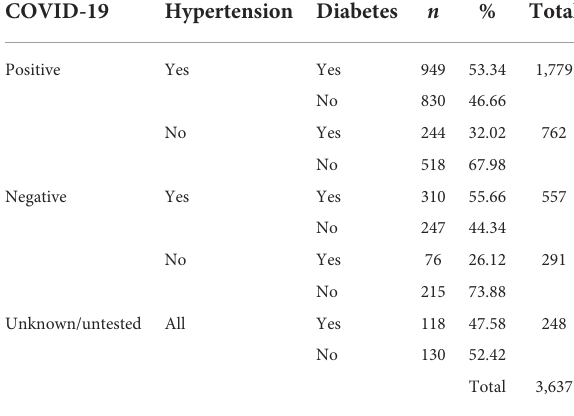
TABLE 2A COVID-19 diagnosis (deaths by year).